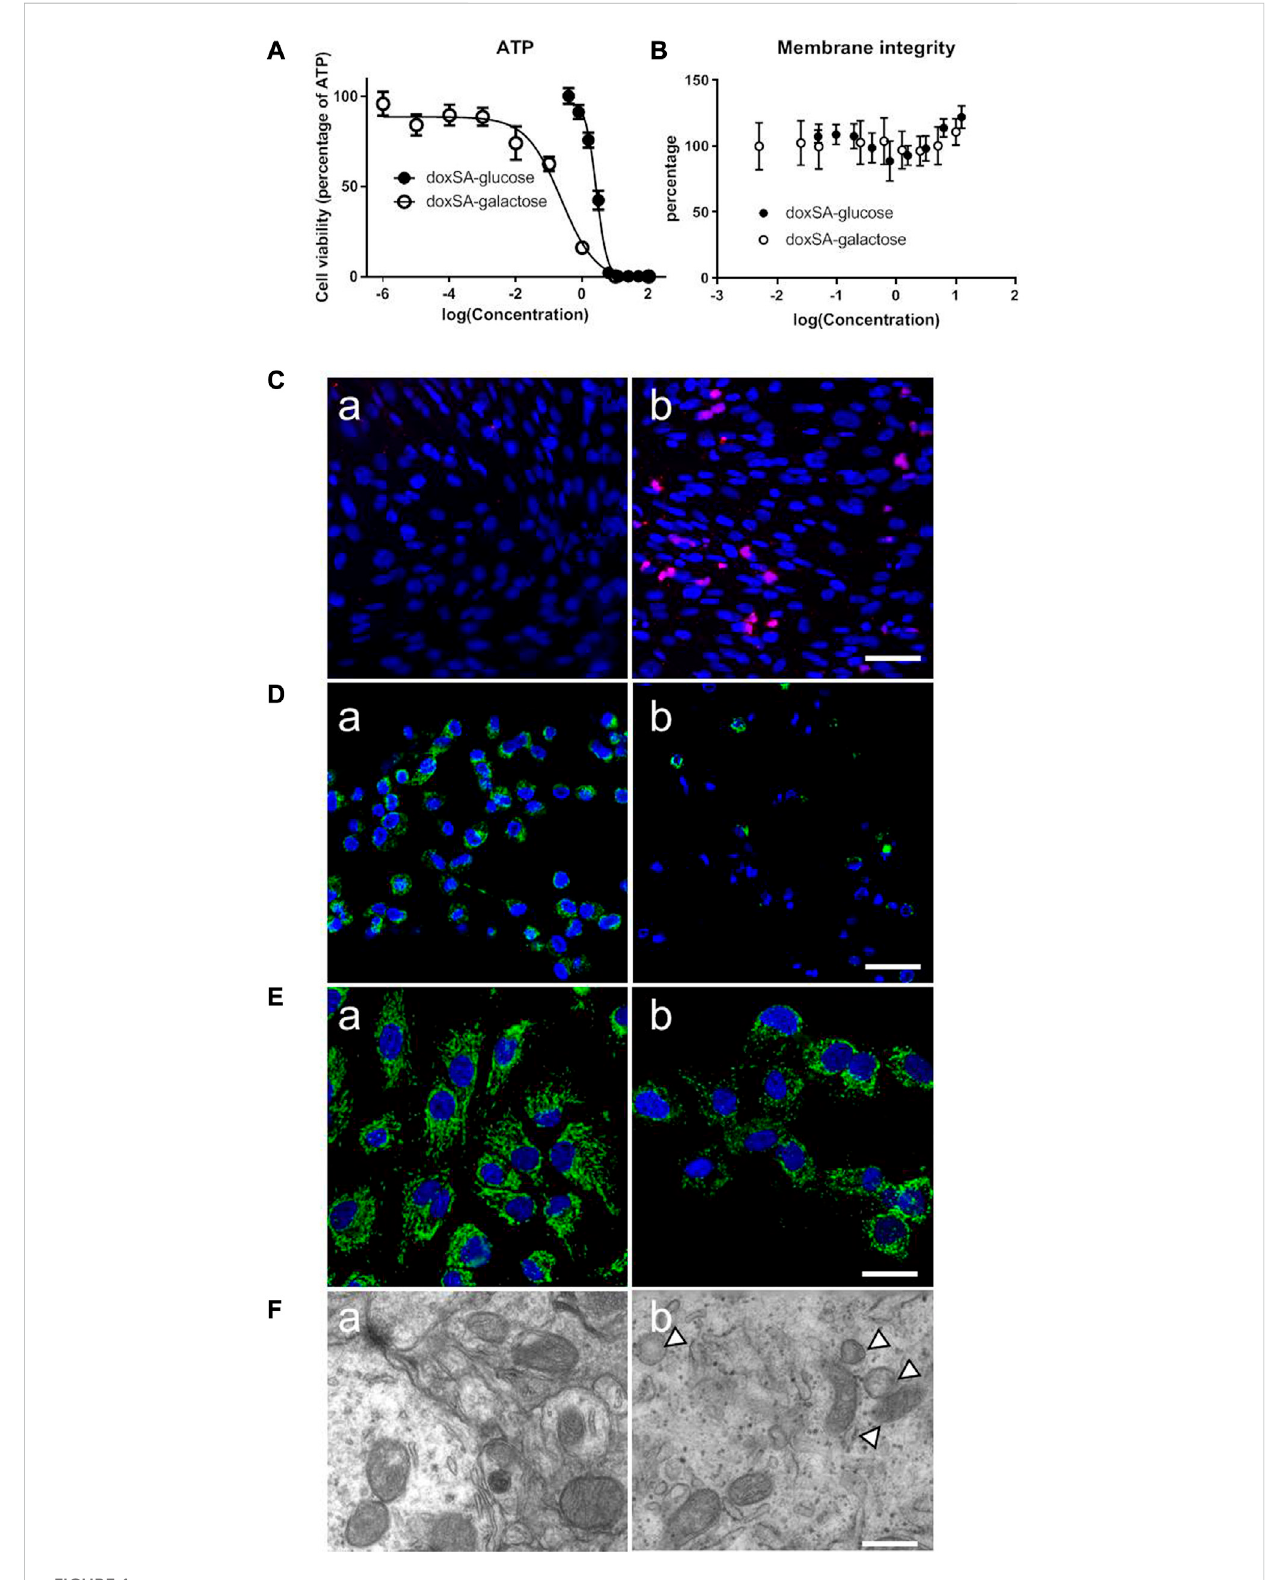
FIGURE 1 Abnormal 1-deoxysphingolipid levels exert cytotoxic effects in HK-2 cells. (A) doxSA induced cell ATP depletion dose-dependently in the culture medium containing glucose or the same amount of galactose, in which the ATP production was switched to be mitochondrial dependent. HK-2 cells in the glucose-free medium were more sensitive to doxSA than those in the medium with the normal glucose. (B) doxSA-induced ATP depletion was cell membrane integrity independent. Representative images of (C) TUNEL staining, (D) rhodamine uptake, and (E) immunostaining for the mitochondrialmembraneproteinTom20,ofHK-2cellsafter (a) vehicle (b) ordoxSA(5 μ M)treatmentfor24 h.Scalebar=50 μ m. (F) RepresentativeTEM images of HK-2 cells after (a) vehicle (b) or doxSA (5 μ M) treatment for 24 h. Scale bar = 150 nm. Arrowheads indicate abnormal